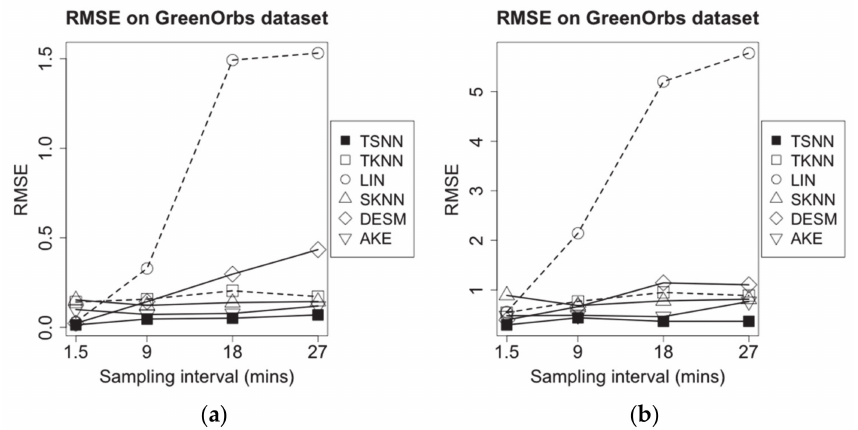
Figure 12. RMSE of imputation algorithms on different data density for GreenOrbs dataset: ( a ) temperature data and ( b ) humidity